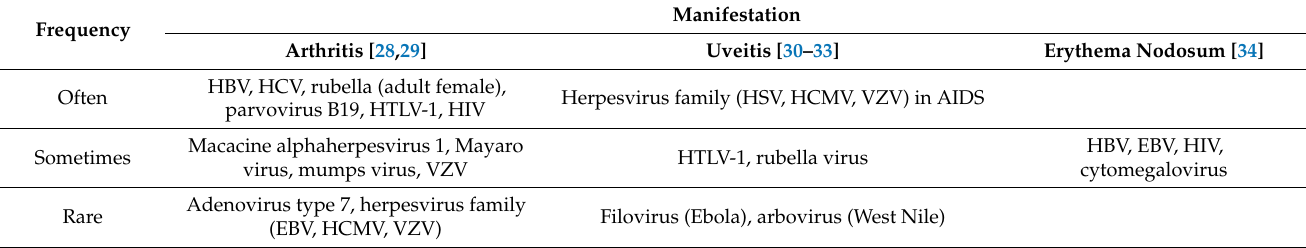
Table 2. Common manifestations of rheumatic diseases caused by viral